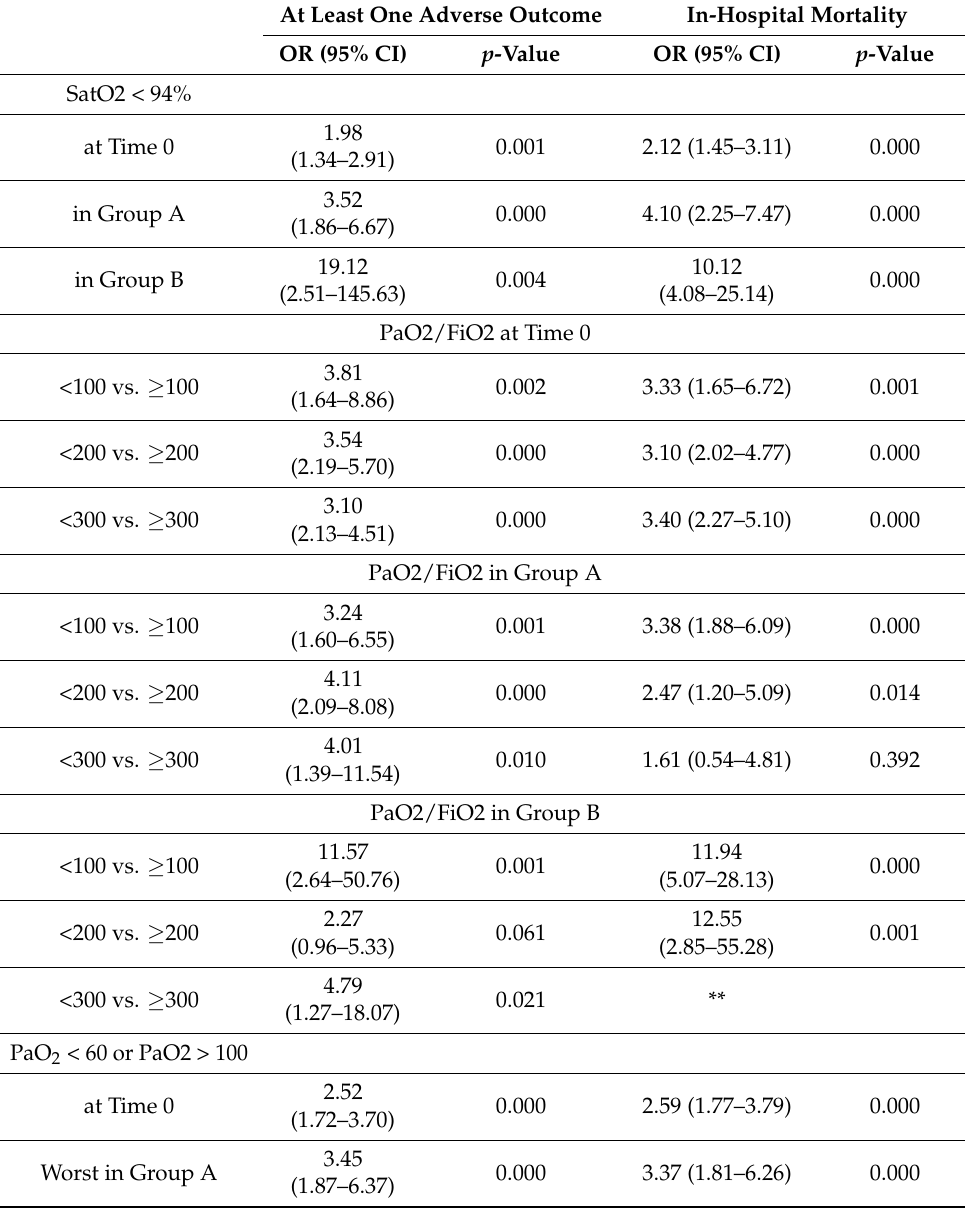
Table 5. OR values (95% CI) related to the comparison of SatO2 < 94% versus SatO2 ≥ 94%, of PaO2/FiO2 category with a threshold of 100, 200 and 300 and of PaO2 < 60 and > 100 versus PaO2 60–100 for the presence of at least one adverse outcome and in-hospital